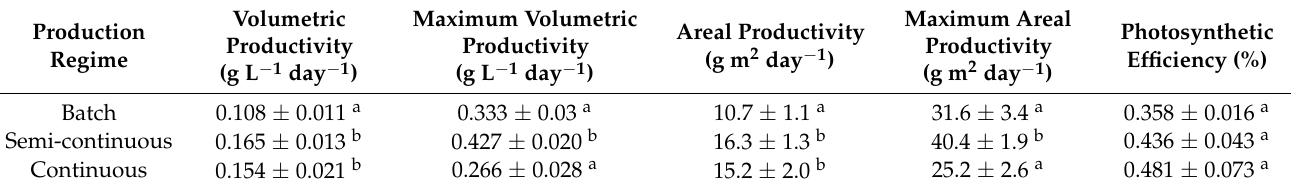
Table 2. Volumetric and areal productivities of biomass during the whole test, and the maximum in a short interval, in the cultivation of Nannochloropsis oceanica , for three operation regimes in 2.6 m 3 PBRs. The values represent the average and standard deviation of three biologically independent replicates. Different letters within the same column represent significantly different values ( p -value <